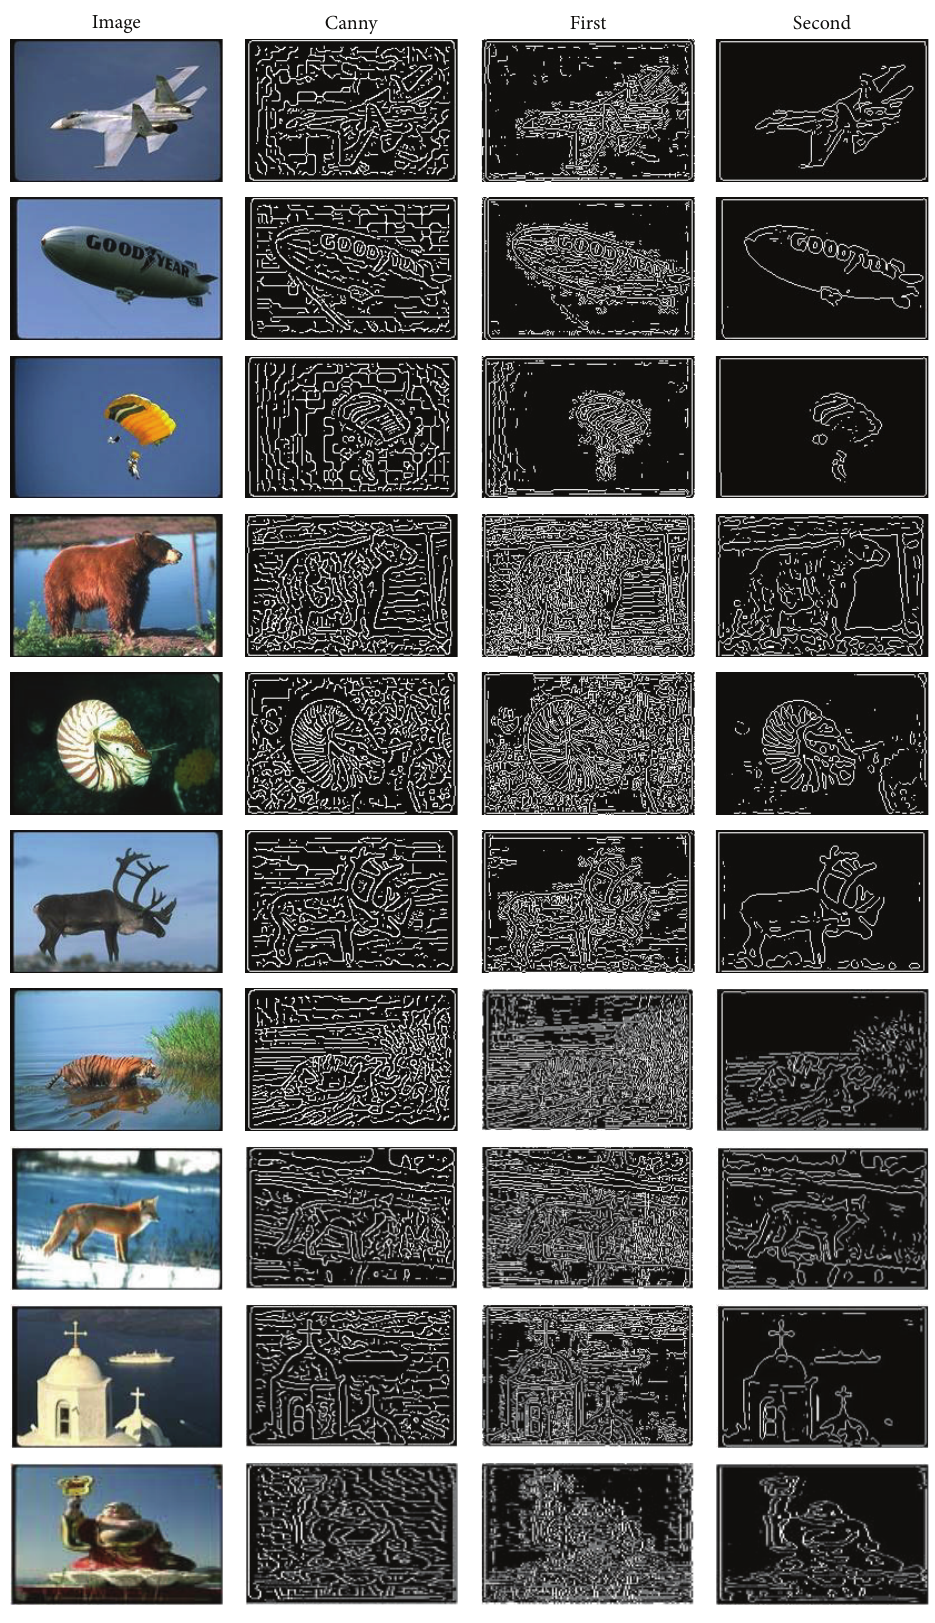
Figure 2: Edge detection results with first and second